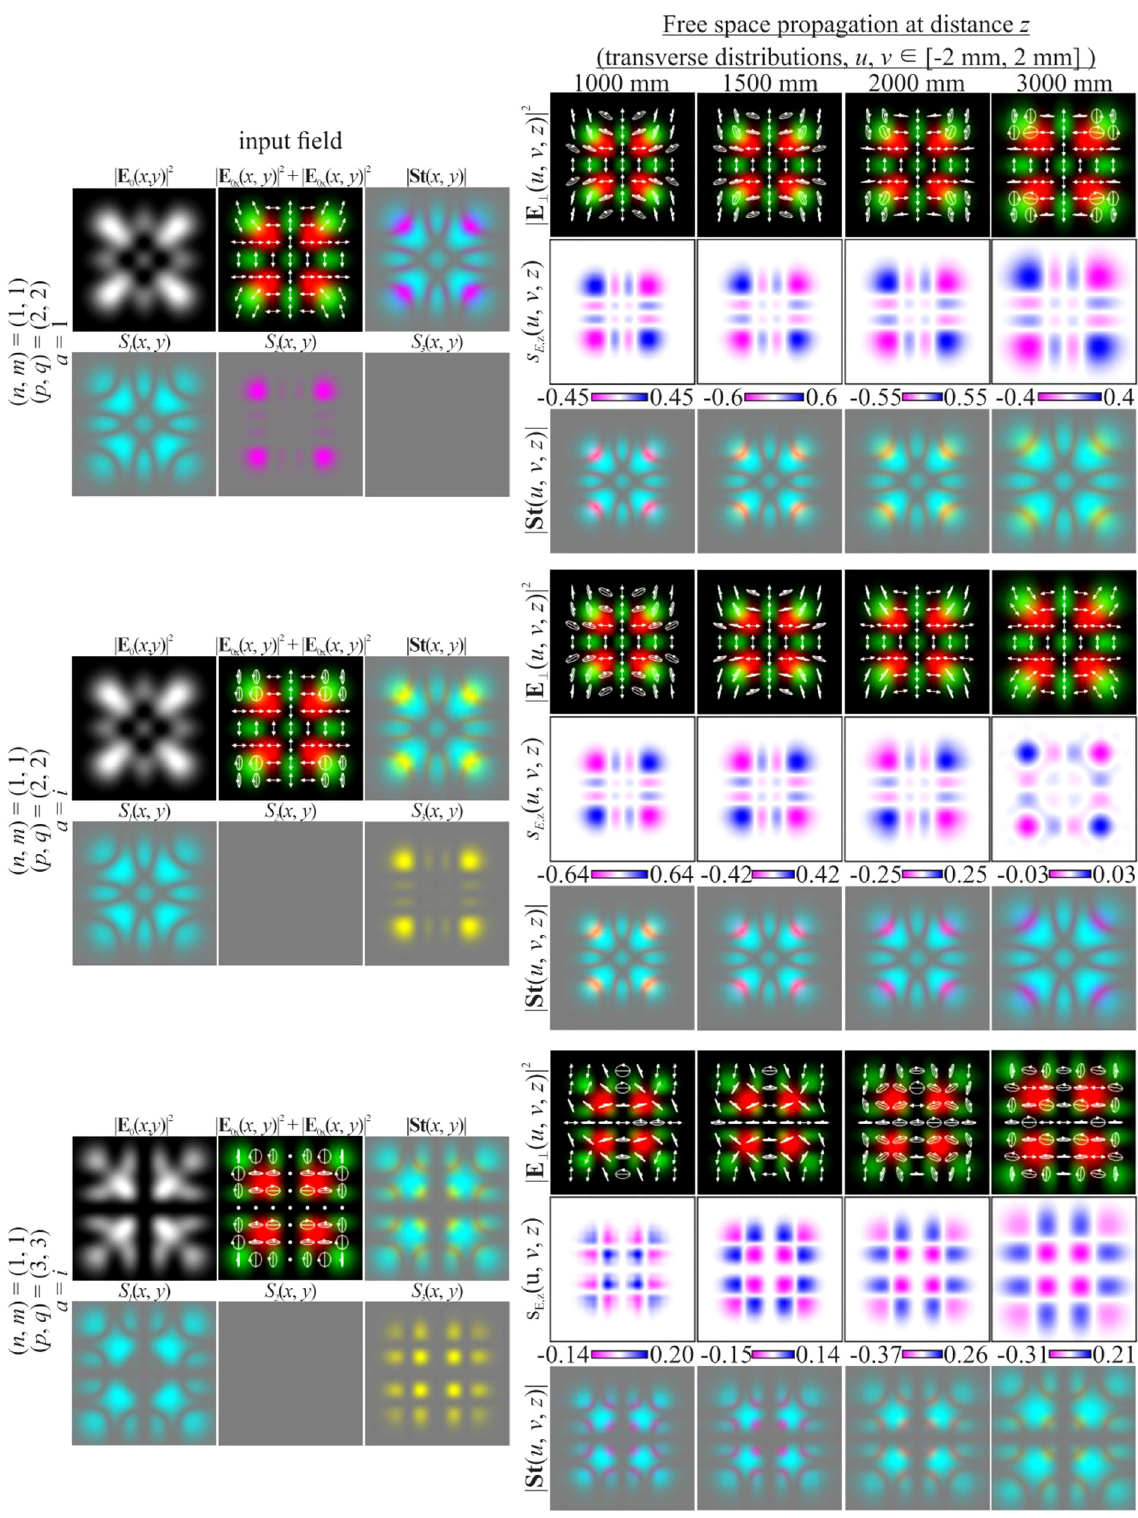
Figure 2: Propagation of inhomogeneously polarized beams defined by Eq. (27) with indices ( n + m ) ≠ ( p + q ) at different initial phase shifts a between the transverse components of the fi